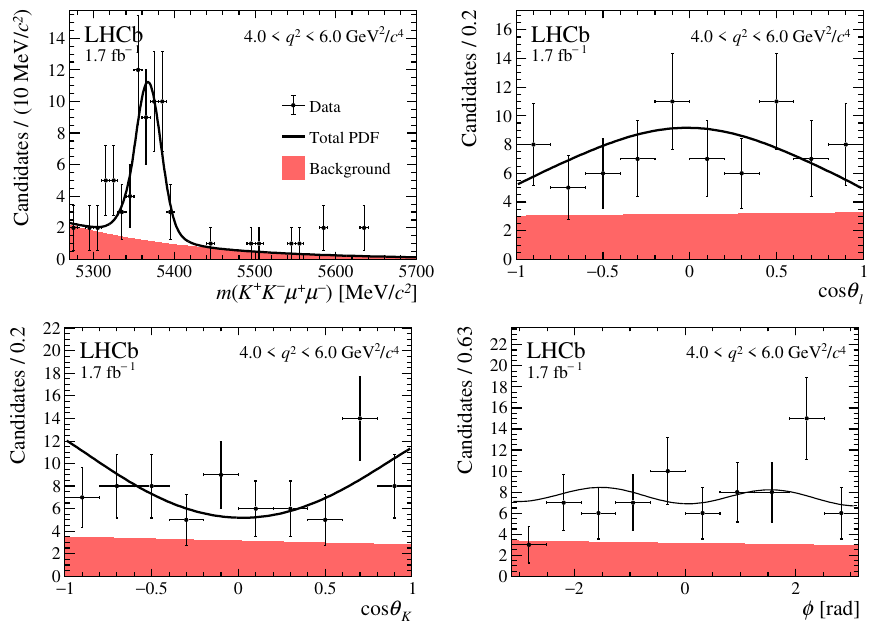
Figure 19 . Mass and angular distributions of B 0 4 . 0 < q 2 < 6 . 0 GeV 2 /c 4 for data taken in 2016. The data are overlaid with the projections of the fitted